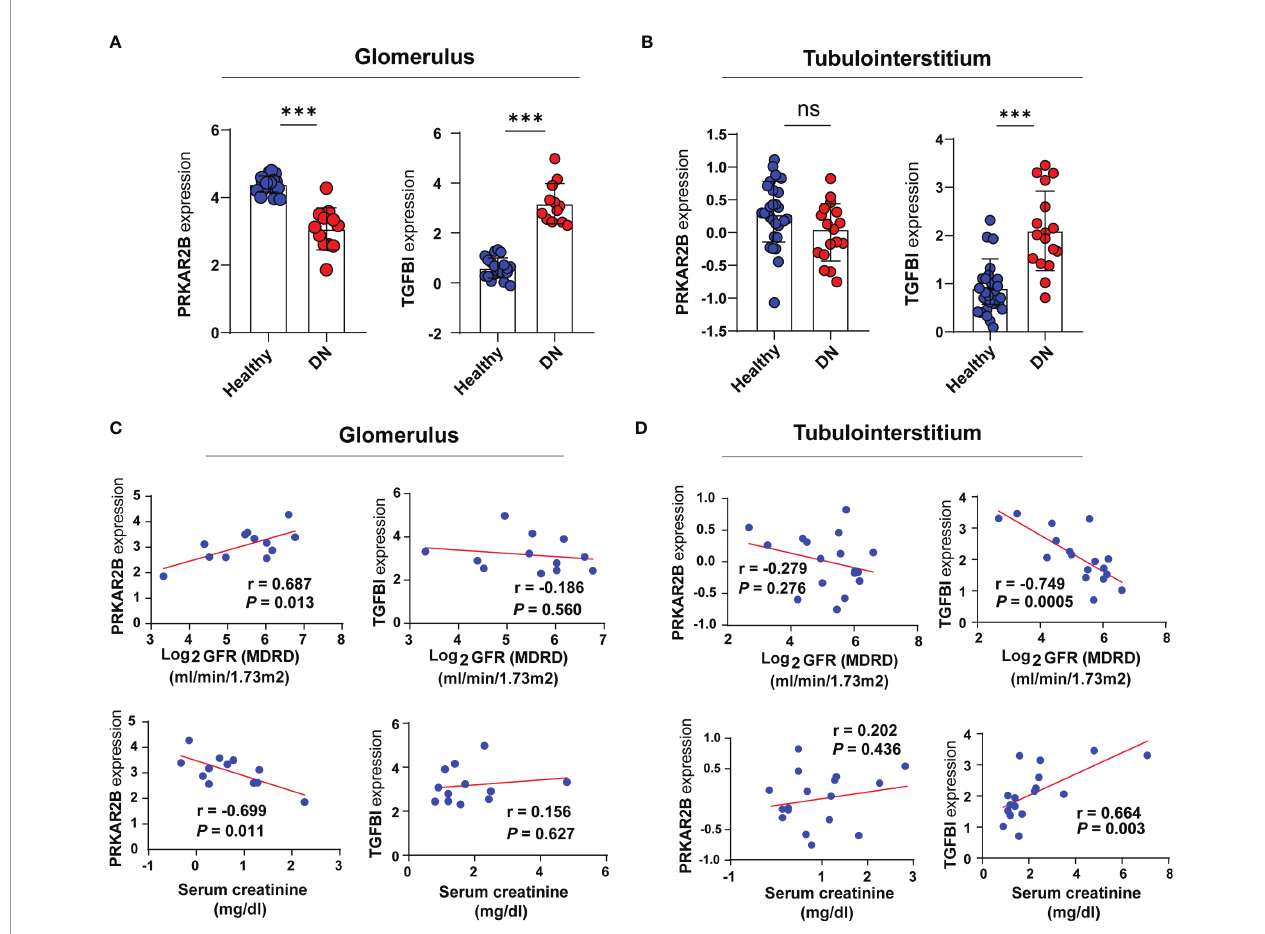
FIGURE 6 | Veri fi cation of the two identi fi ed biomarkers. (A, B) The expression patterns of the identi fi ed biomarkers. (C, D) Correlation analysis between the expression of the biomarkers and renal function indexes. *** p < 0.001 vs. healthy subjects. ns, not signi fi